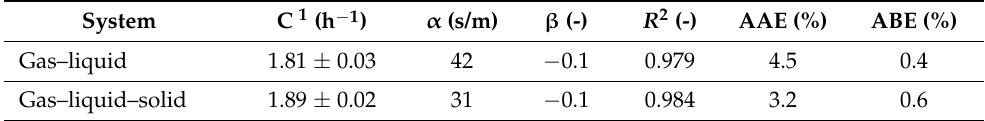
Table 17. Overall volumetric mass transfer coefficient k L a : Evaluated parameters of correlation